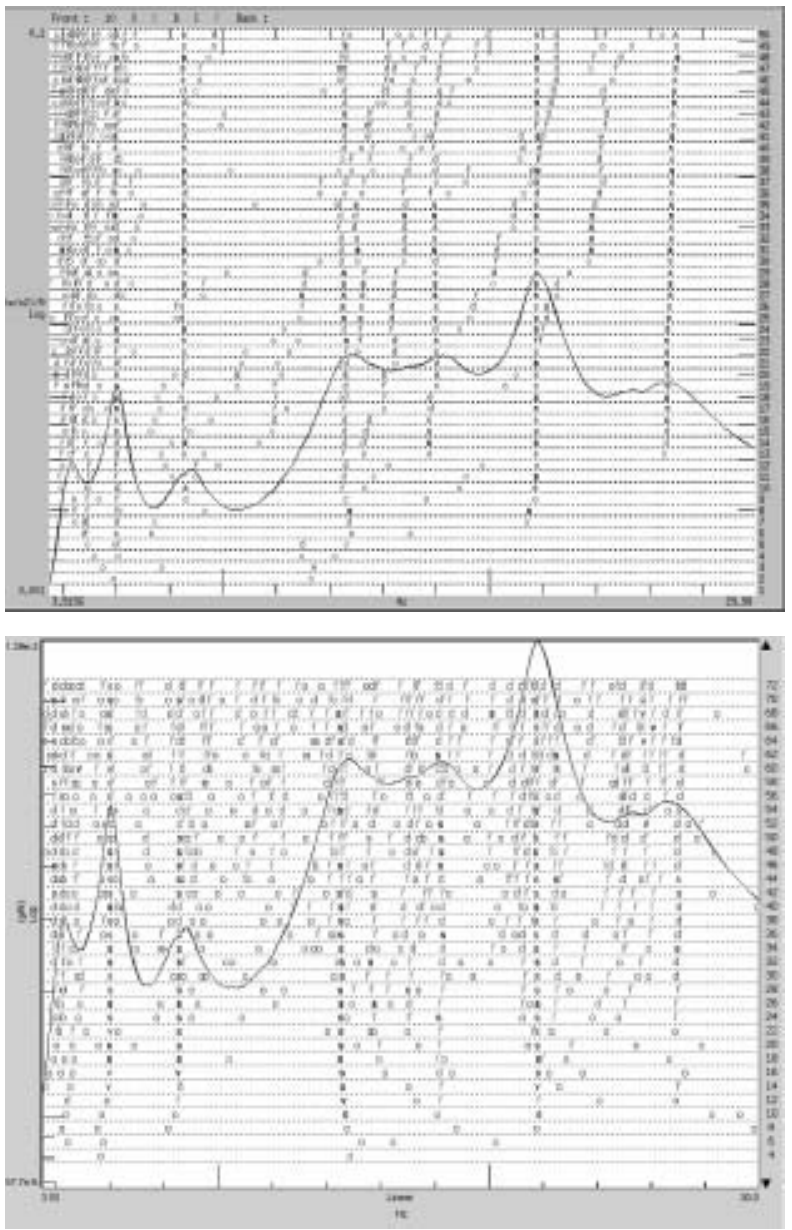
Fig. 1. Stabilisation diagrams obtained by applying different parameter estimation methods to the Porsche data: (Top) FDPI; (Middle) LSCE; (Bottom) the new PolyMAX method. poles tend to “wander” in the stabilisation diagram, especially at large model orders. The PolyMAX method has the interesting property that the non-physical poles are estimated with a negative damping ratio so that they are easily excluded from the set of poles before plotting them. Such a clear diagram does not mean that some of the poles are missing; on the contrary, more (physical) poles can be found than with the earlier state-of-the-art methods, as evidenced by the examples in next section. Other validation studies also revealed that the PolyMAX method has no problems in correctly estimating modes having a low damping ratio. It is sometimes stated that time-domain